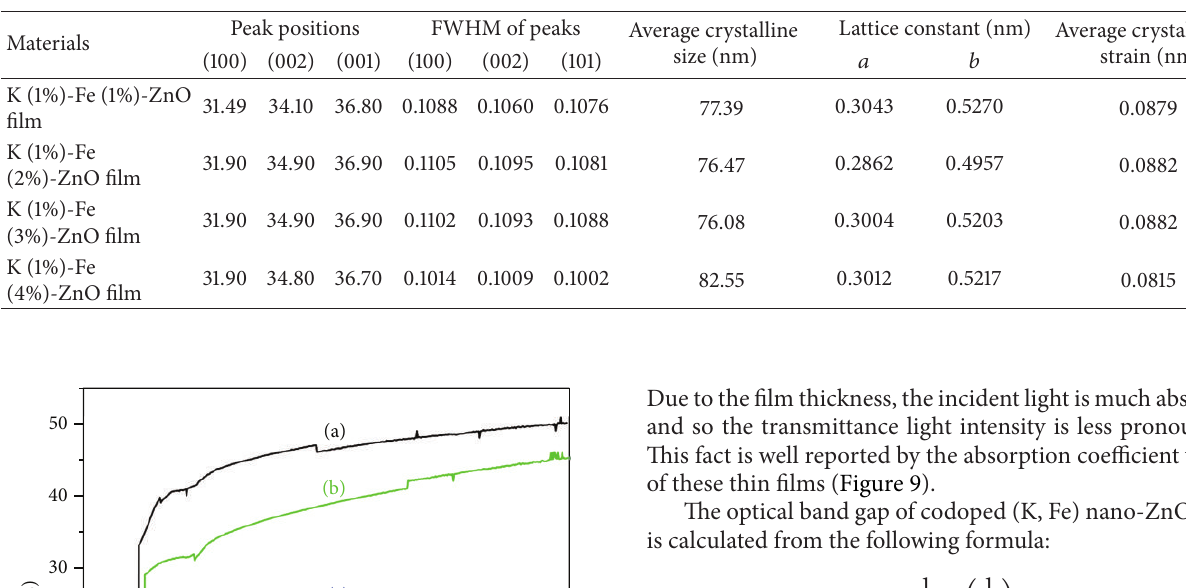
Table 1: The peak position, FWHM, average crystalline size, lattice constant, and average lattice strain for the (K, Fe) codoped ZnO thin films.